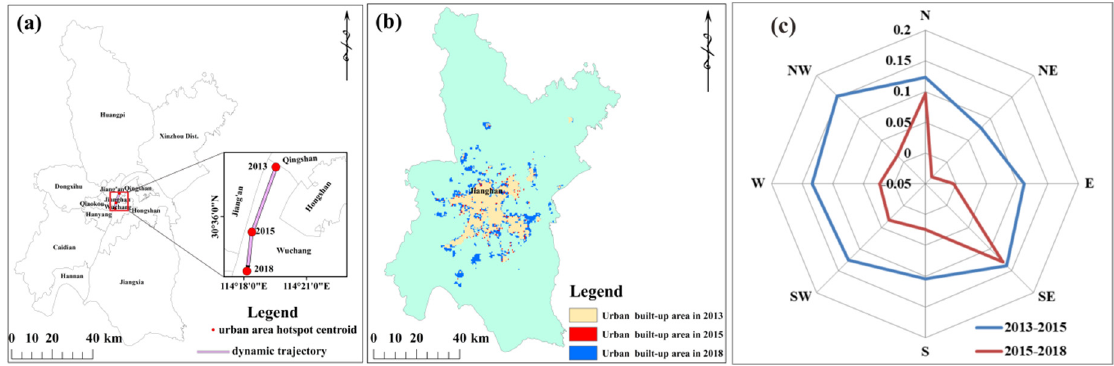
Figure 12. Consistency between the movement of urban area hotspots and urban expansion variation: ( a ) the movement of gravity center in Wuhan; ( b ) urban built-up area dynamics during 2013–2018; ( c ) expanding intensity of Wuhan from 2013 to 2018.